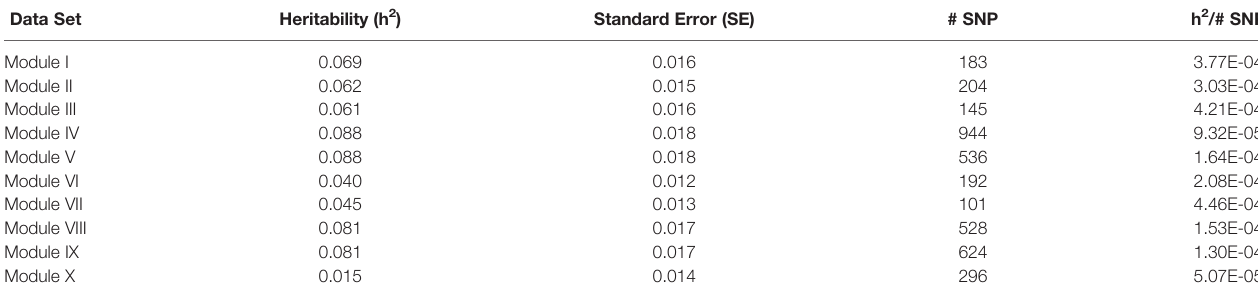
TABLE 5 | Heritability estimates for feed ef fi ciency from unweighted genome-wide association studies (GWAS) utilizing SNP with weight > 5. Data